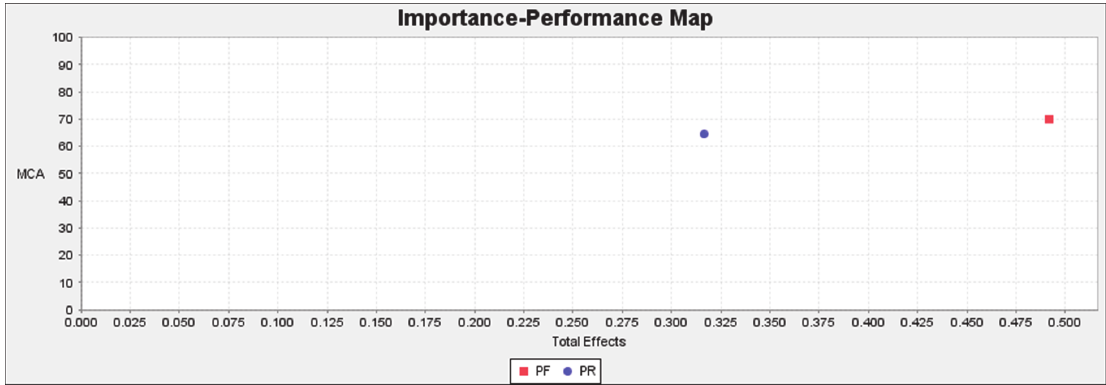
Fig. 3. Importance Performance Matrix.